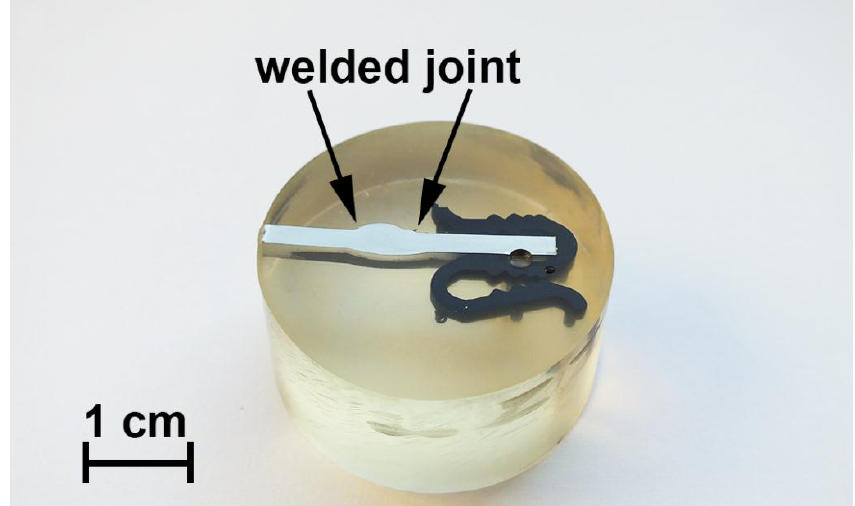
Figure 1. Image of the cross-section of the 1579 aluminium alloy with a welded joint zone. The sample was made for scanning vibrating electrode technique and scanning ion-selective electrode technique (SVET/SIET) measurements.